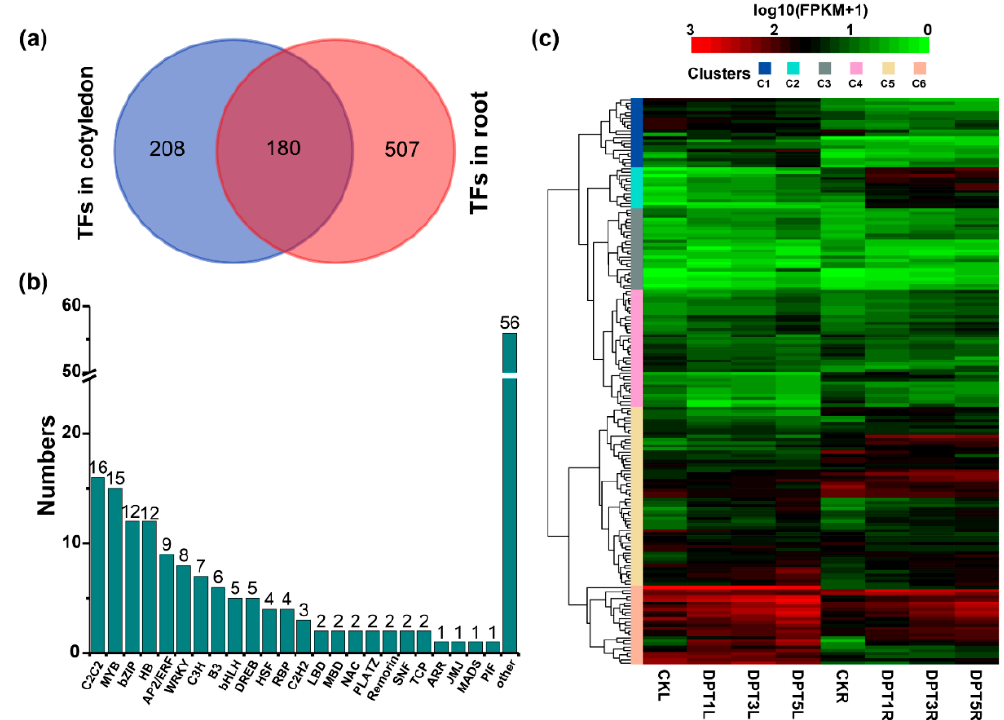
Figure 6. The differentially expressed TFs in cotyledons and roots responsive to drought stress. ( a ) Venn diagrams of TFs between cotyledons and roots. ( b ) Classification of TFs that were commonly identified in both cotyledon and root transcriptome libraries. ( c ) Expression pattern of TFs that were commonly identified in both cotyledons and roots in response to drought stress.